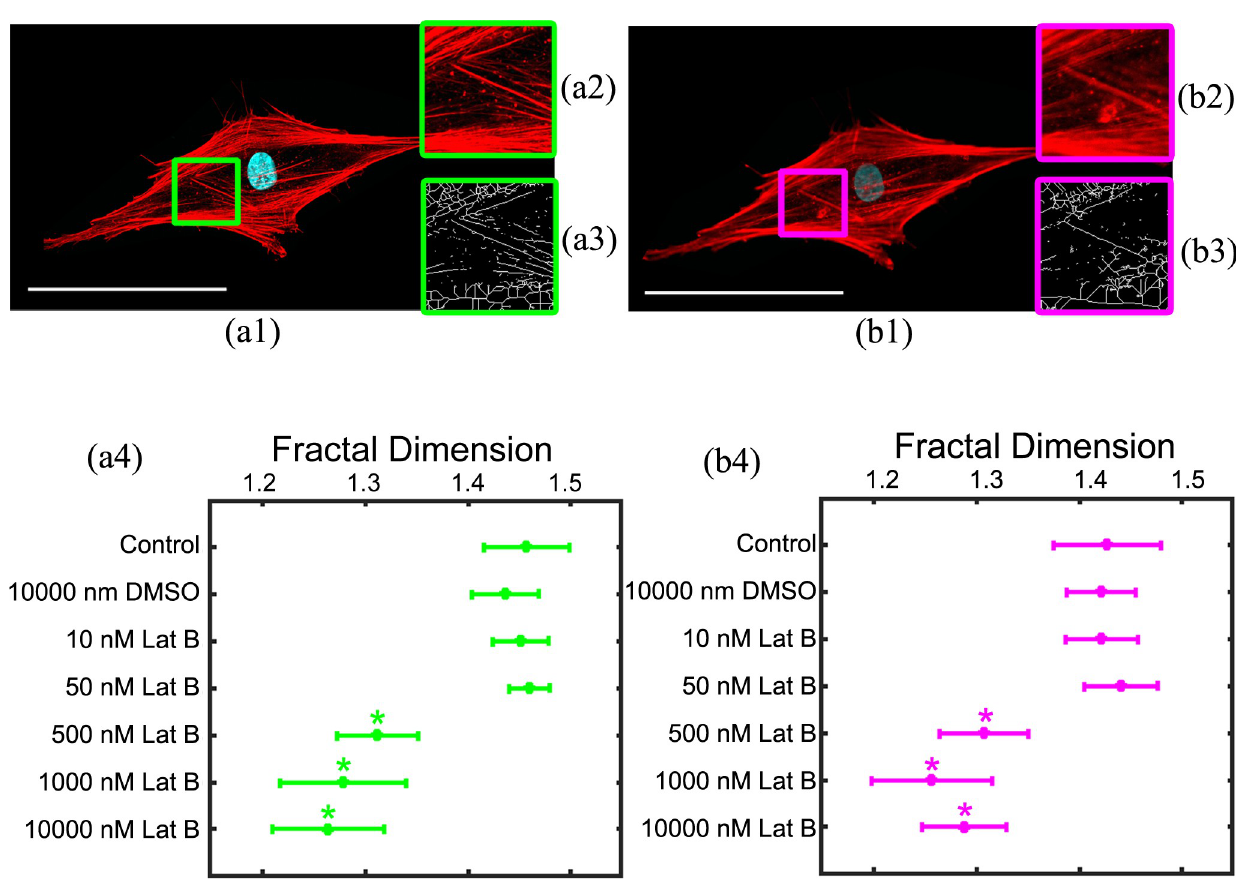
Fig 5. FD analysis of F-actin changes after treatment with Lat B using confocal or imitating widefield fluorescent microscopy. Images of random cell from the control group were obtained by confocal (a1) or widefield fluorescent (b1) microscopy. Scale bar size is 100 μ m, (a2) and (b2) show double-scaled images, and (a3) and (b3) show its’ skeletonized versions. (a4) and (b4) represent FD mean values and their standard deviations calculated for groups of control and Lat B-treated cells (n = 15 cells in each group) where F-actin images were obtained by confocal or imitating widefield fluorescent microscopy respectively. ( � ) comparing to DMSO-treated control group, p < 0.05, each group is n = 15